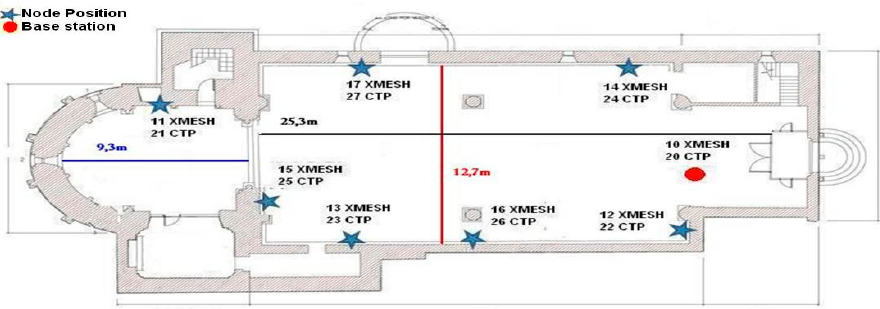
Figure 2. WSN deployment in the church of Talamanca de Jarama.